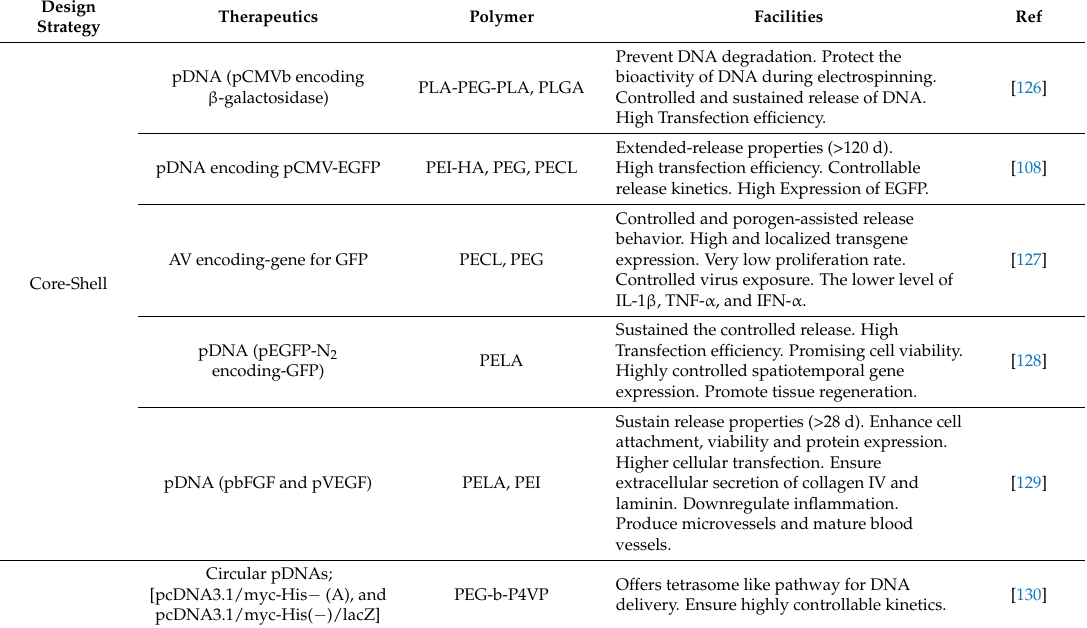
Table 1. Electrospun nanofiber-based DNA/RNA